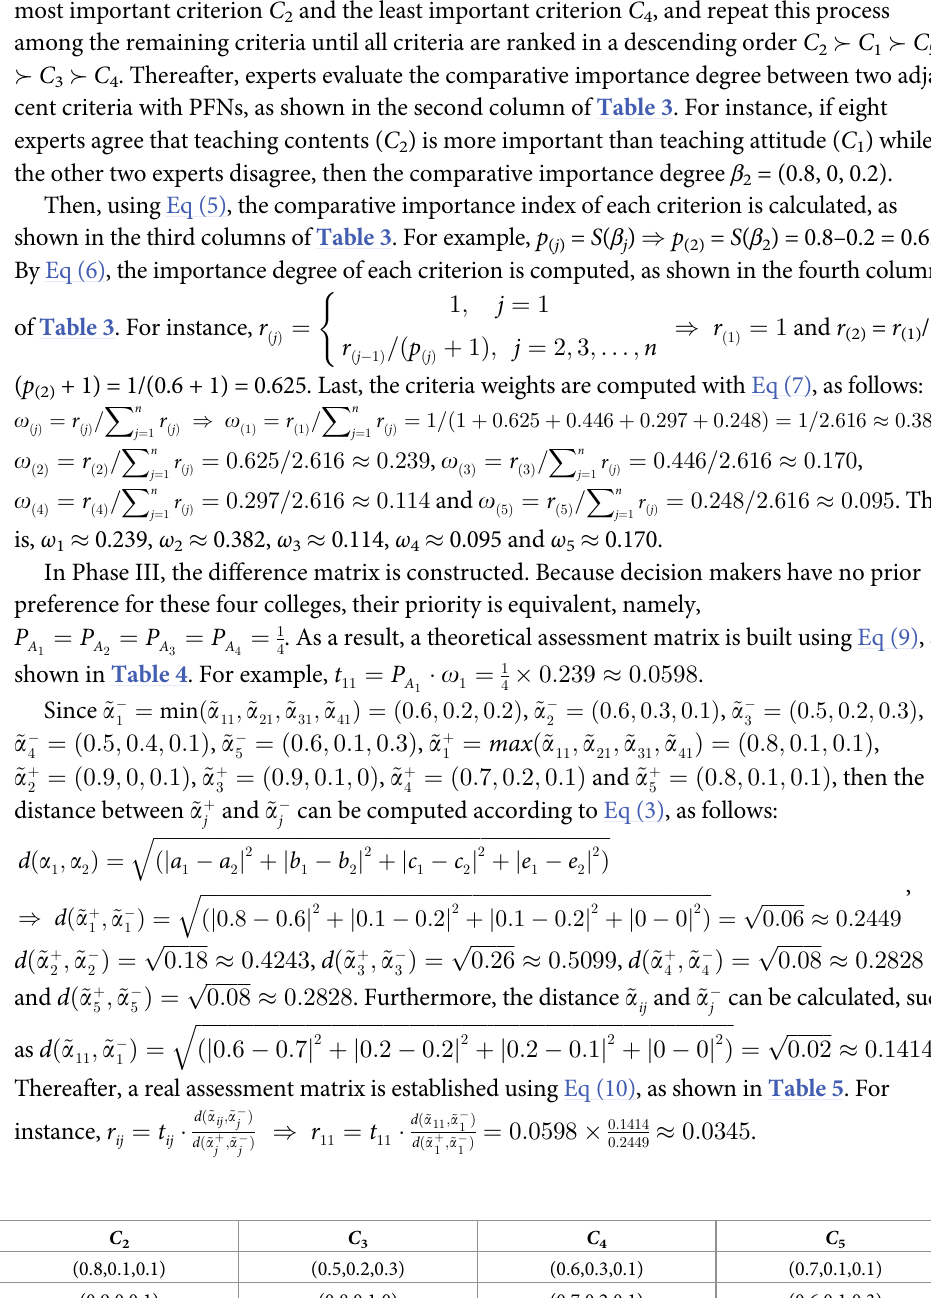
Table 2. Initial evaluation matrix E